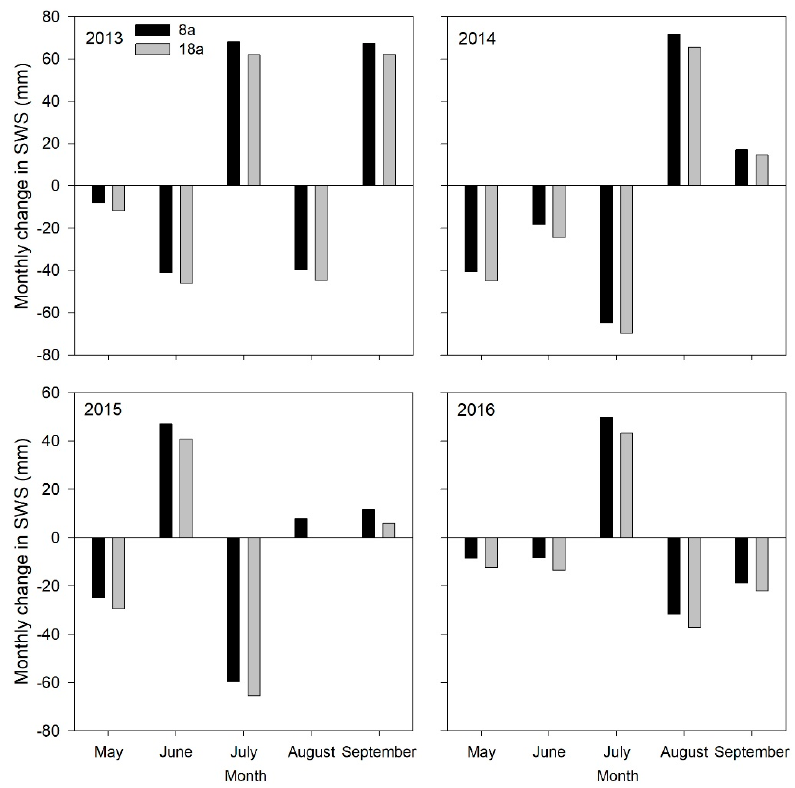
Figure 6. Monthly change in soil-water storage (SWS) for the 8- and 18-year-old apple orchards (8a and 18a, respectively) in 2013, 2014, 2015, and 2016.